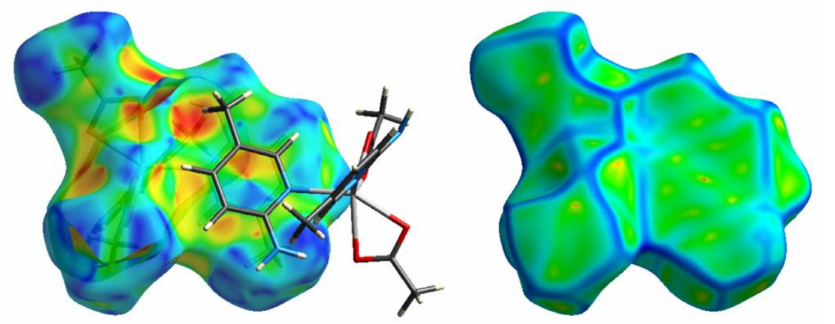
Figure 12. Red/blue triangles in shape index ( left ) and flat green surface in curvedness ( right ) revealed the presence of π - π stacking interaction in 3 .